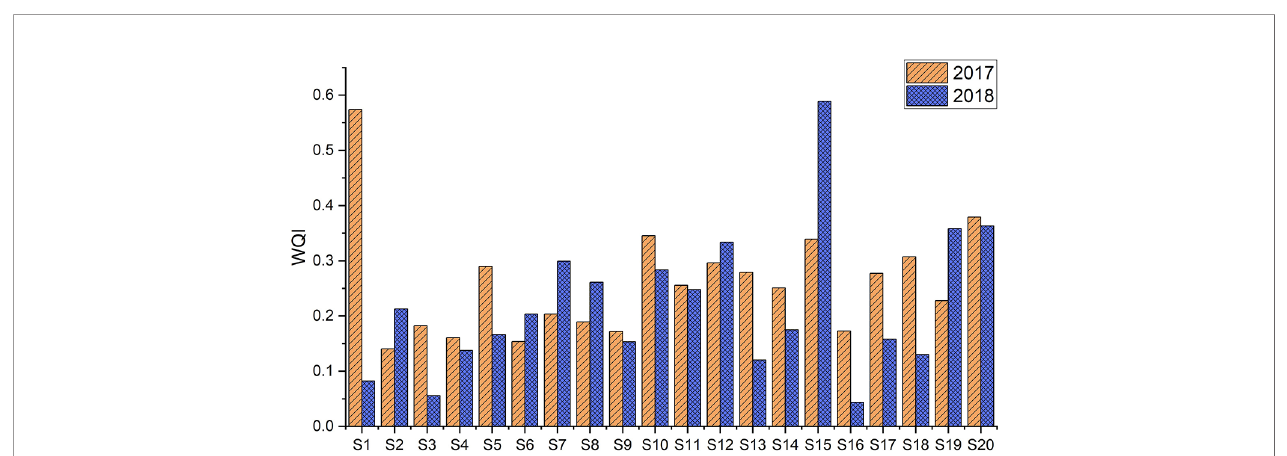
FIGURE 4 | WQI of heavy metals in surface seawater of Zhuhai.